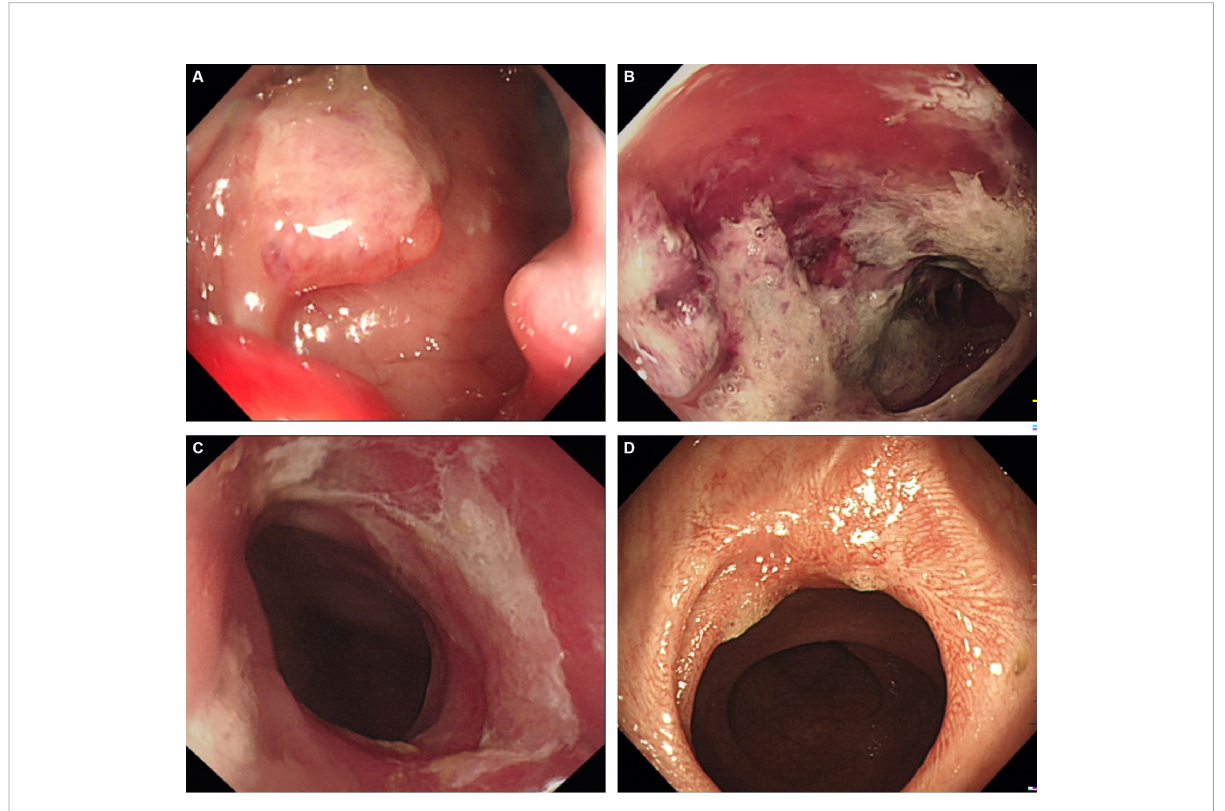
FIGURE 3 A representative case of achieving complete response after PDT. (A) The cauli fl ower-like protrusion was seen on the lateral wall of the rectum, and the clinical stage is stage IIIB; (B) 48h after PDT, a large amount of gray necrotic tissue was formed at the lesion site, with hyperemia and edema at the edge; (C) One month after PDT, the lesion ’ s surface was covered with a small amount of residual necrotic tissue, and the tumor almost disappeared; (D) Three months after PDT, the tumor tissue disappeared and a scar formed. Biopsy con fi rmed that the tumor cells were negative, so complete remission was